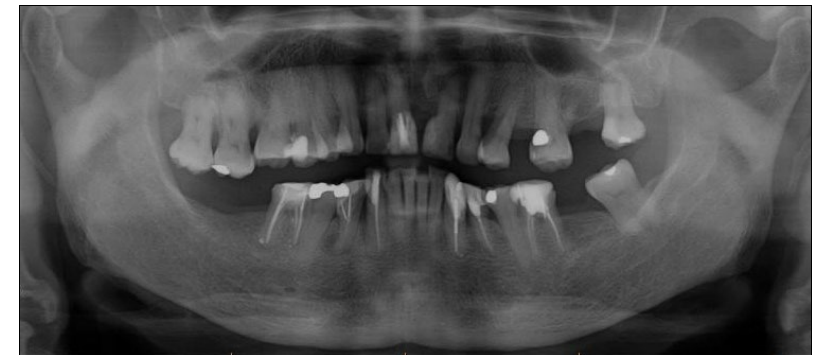
Figure 1. Pretreatment panoramic radiograph.